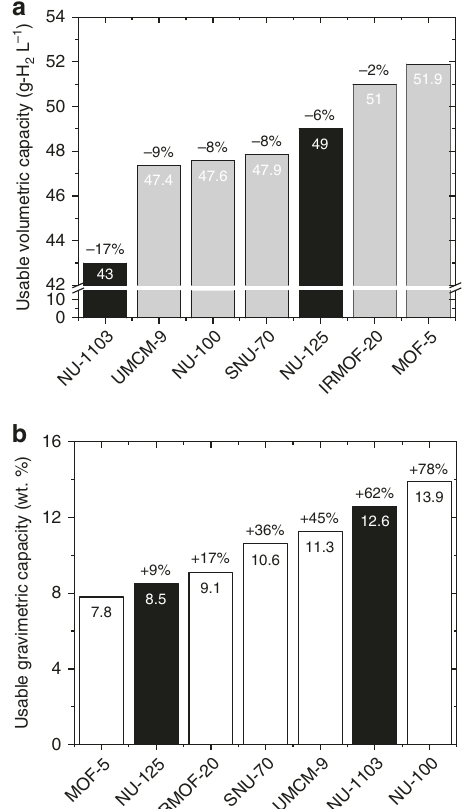
Fig. 7 Comparison of measured usable H 2 storage capacities of MOFs assuming temperature + pressure-swing operation between 100 bar-77 K and 5 bar-160 K. a Volumetric capacity, and b gravimetric capacity. Grey bars depict the performance of compounds reported in the present study or in the authors ’ earlier report 1 . Black bars depict the performance of two high-capacity MOFs reported in ref. 53 . Percentages on top of each bar depict performance relative to